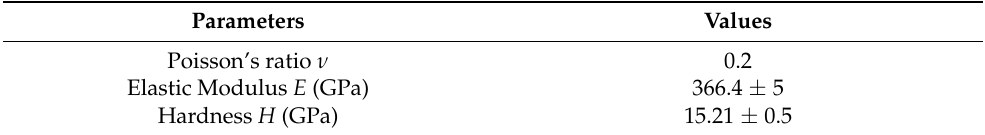
Table 1. Mechanical properties of AlN ceramics.